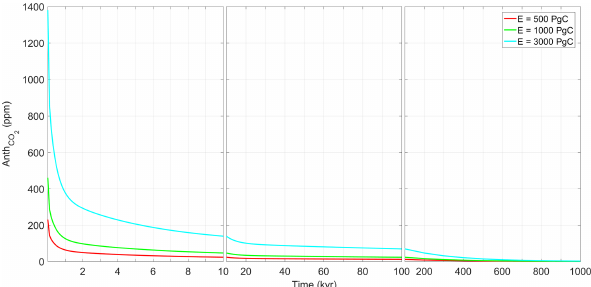
( t ) expressed in parts per million (ppm) follow- Figure 6. Anth CO 2 ing Lord et al. (2016) for the three different emission scenarios con-